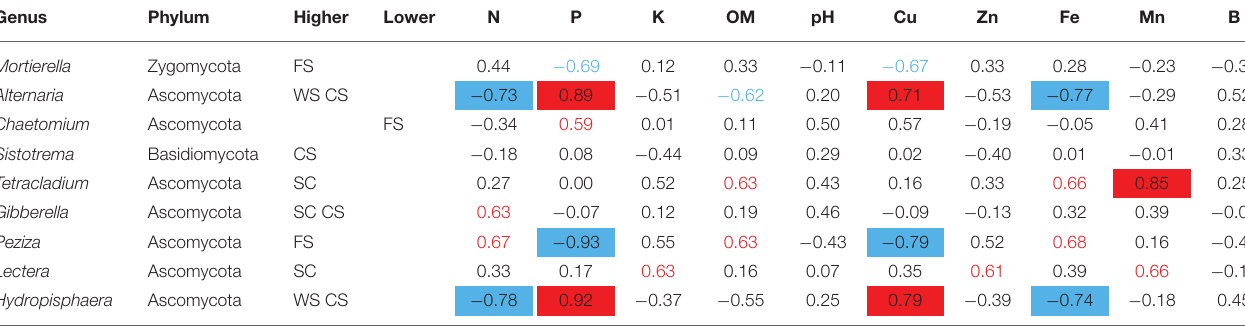
TABLE 3 | Relationships between dominant fungal species and soil physico-chemical properties. Genus Phylum Higher Lower N P K OM